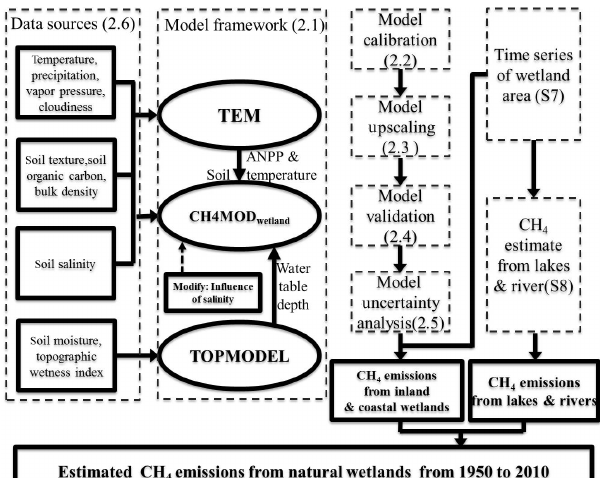
Figure 1. Framework of simulating CH 4 emissions from natural wetlands between 1950 and 2010 in China. CH4MOD wetland is a biogeophysical model to simulate CH 4 fluxes from natural wet- lands. TEM is a process-based biogeochemistry model that couples carbon, nitrogen, water, and heat processes in terrestrial ecosystems to simulate ecosystem carbon and nitrogen dynamics. TOPMODEL is a conceptual rainfall–runoff model that is designed to work at the scale of large watersheds using the statistics of